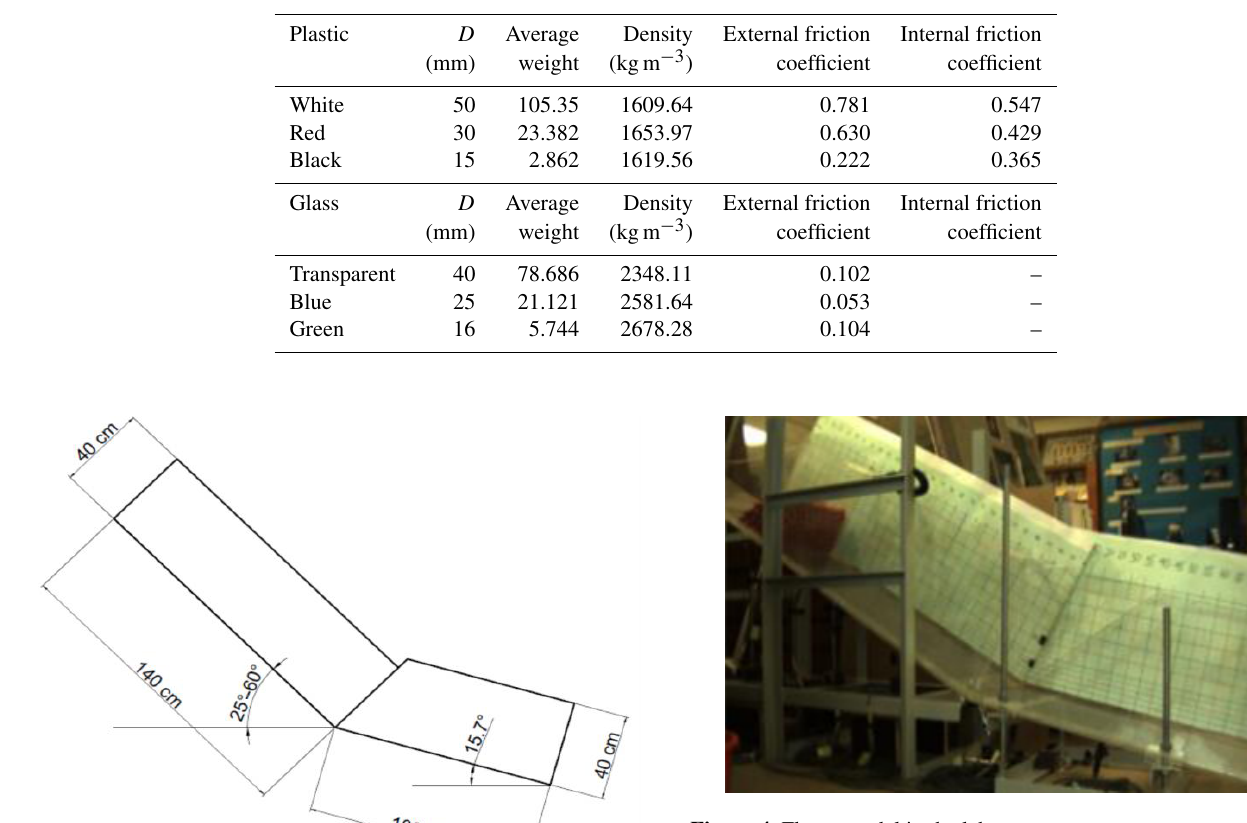
Figure 4. Flume model in the laboratory.